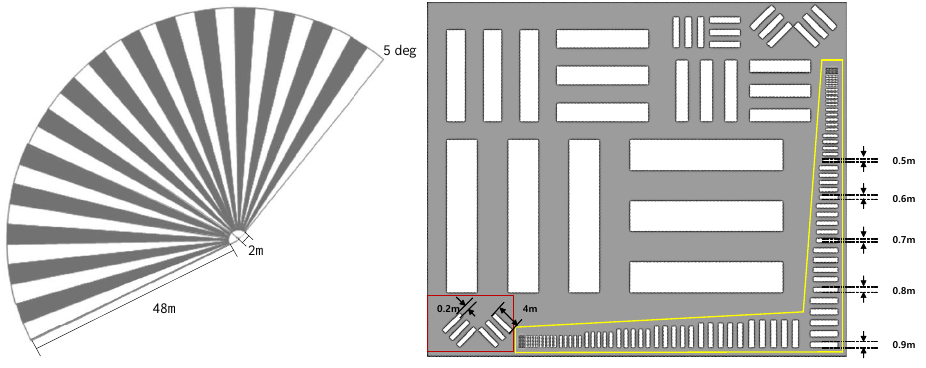
Figure 12. Targets design and specification of Baotou